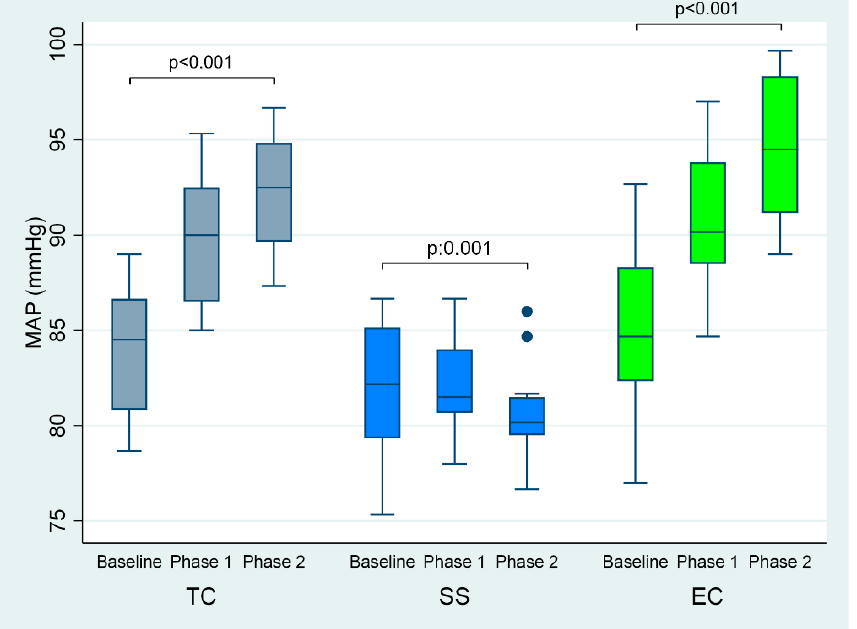
Figure 2. MAP at baseline and phases 1 and 2 of TC, EC and sham smoking. EC, electronic cigarette; MAP, mean arterial pressure; TC, tobacco cigarette., SS=sham smoking